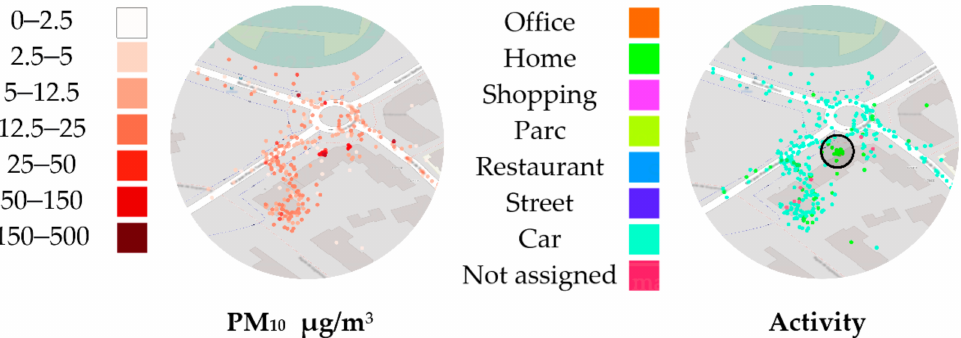
Figure 9. Point of interest for particulate matter (PM 10 ) B, close up of “Home.”